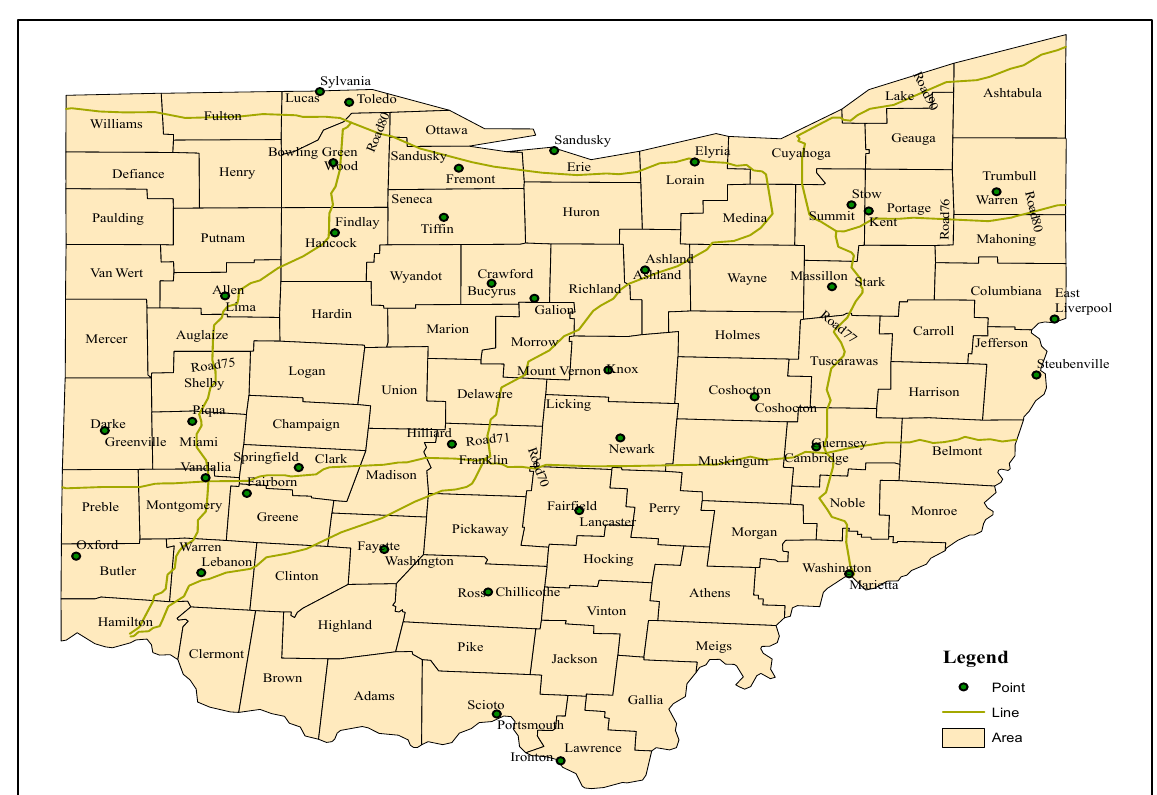
Figure 12. Result of the third dataset using the proposed algorithm.